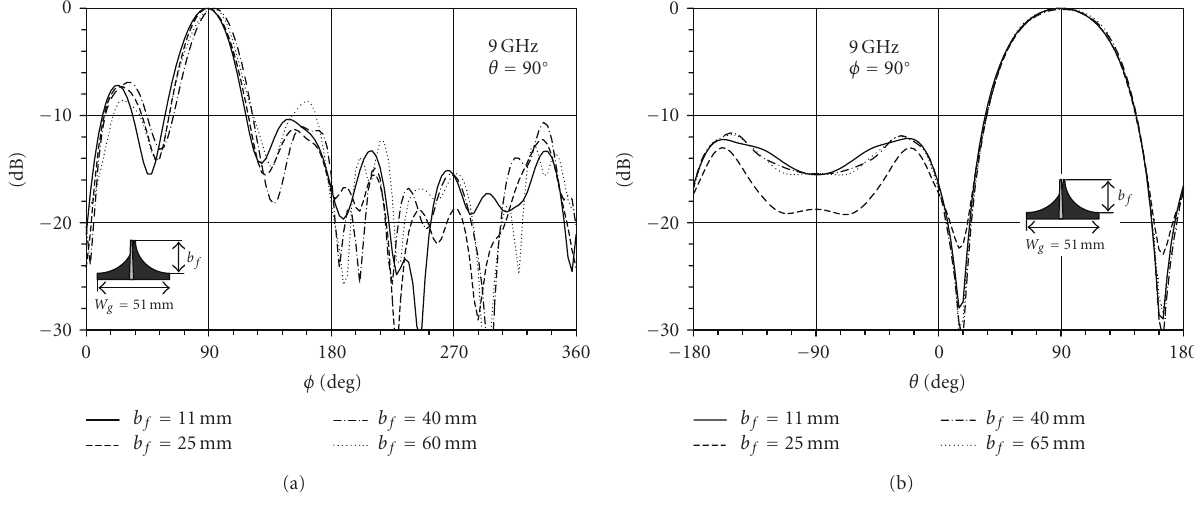
Figure 14: Radiation patterns of DETASAs for changing length of tapered ground, b f , in (a) E-plane, (b) H-plan.